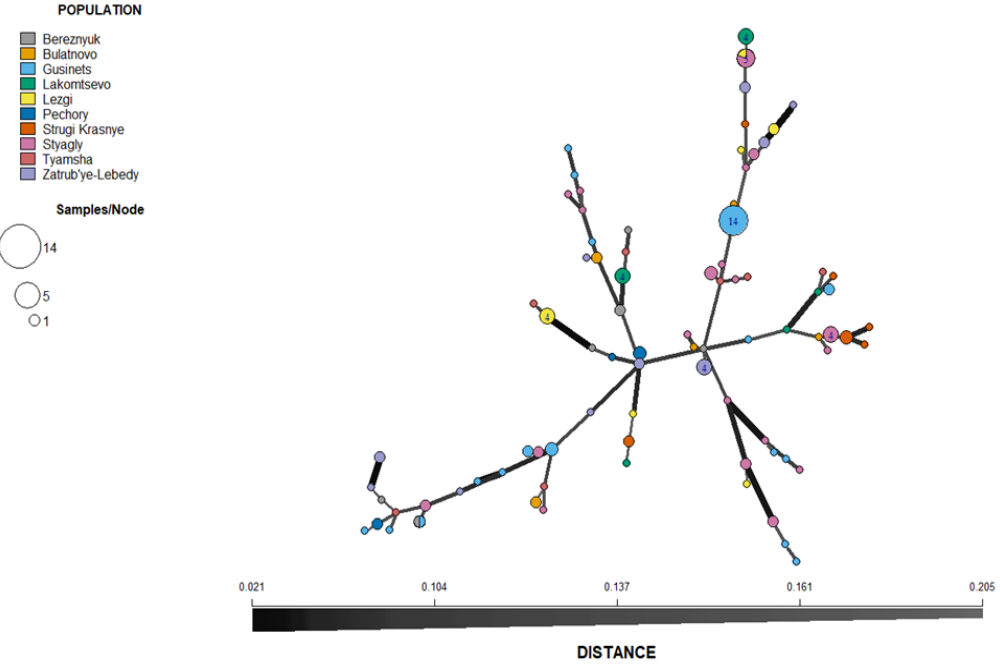
Figure 5. Minimum spanning network (MSN) inferred from simple sequence repeat (SSR) markers of P. infestans collected from ten locations (non-clone corrected) of Pskov region in north-west Russia during years 2010–2013. Each node represents multilocus genotypes (MLGs) and the size is proportional to the number of individuals sharing the same SSR allele profile. The thickness of the lines represents the Bruvo’s genetic distance between two nodes (the further the genetic distance the lighter the color and thinner the line). MLGs from the same location are color-coded.